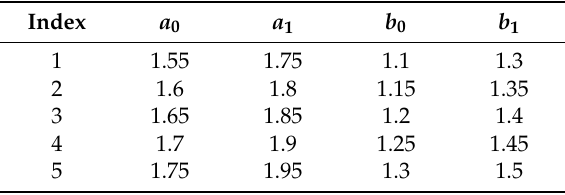
Table 9. Different Values of a 0 , a 1 , b 0 , and b 1 for sensitivity analysis of (1, 0).